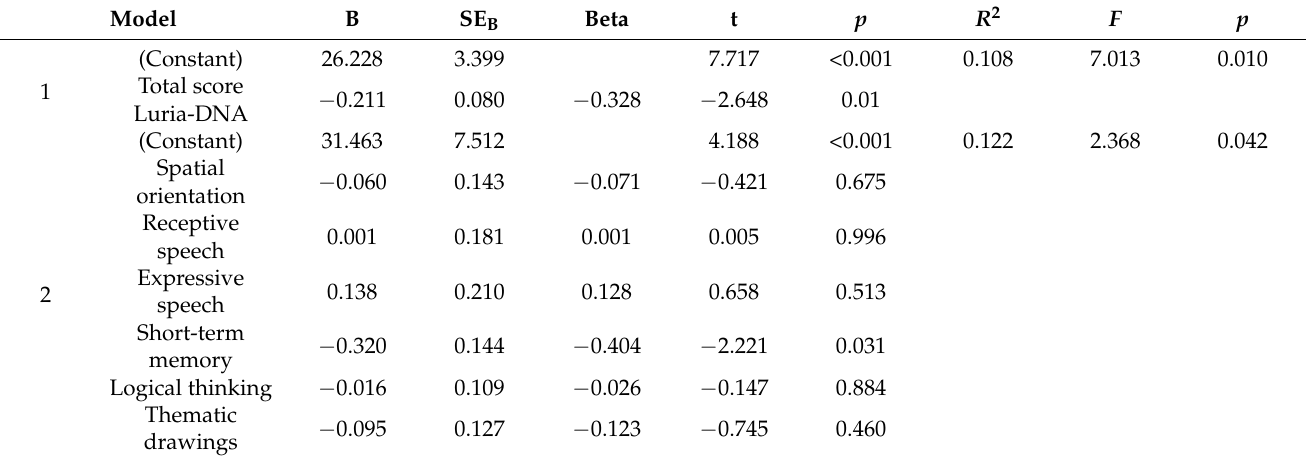
Table 2. Regression analysis for neuropsychological variables predictive of depressive